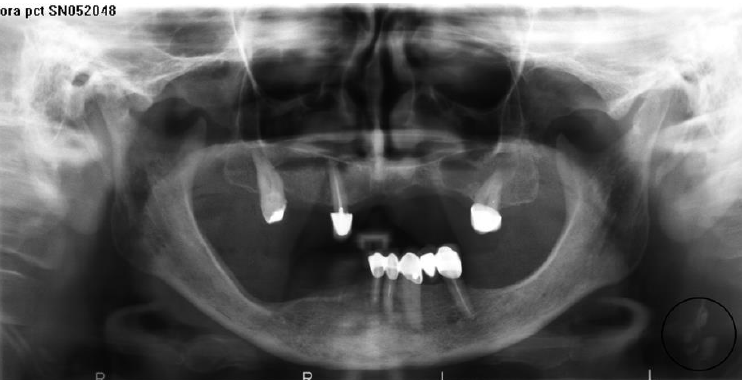
Figure 1. Unilateral carotid artery calcifications (in circle on the left).